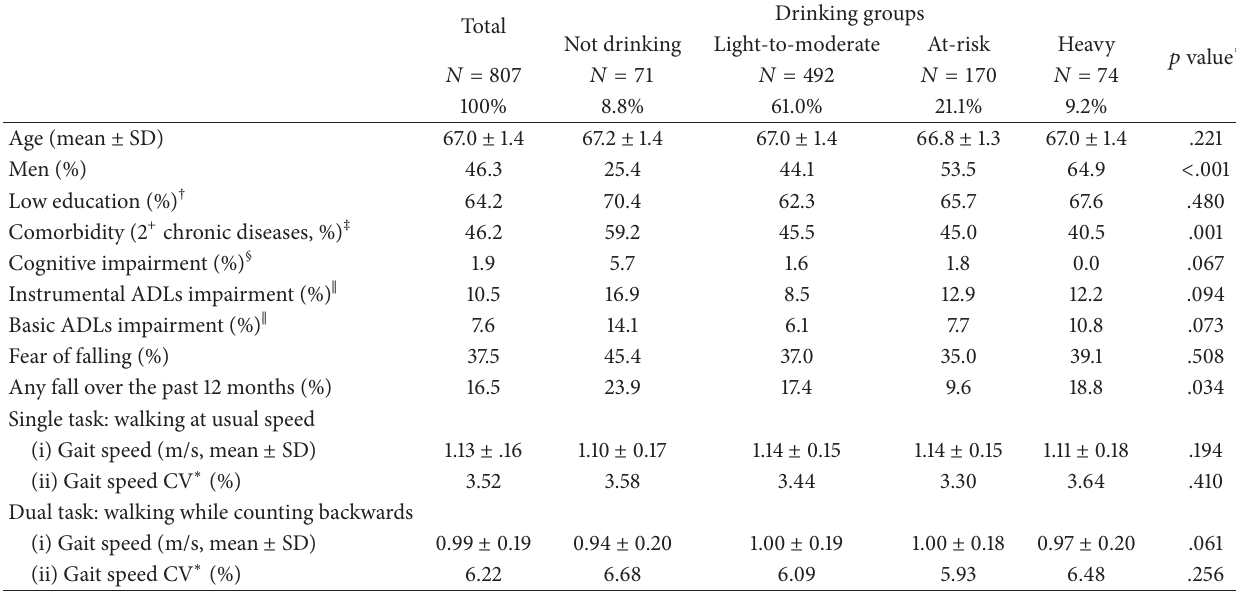
Table 1: Characteristics of participants and comparison according to alcohol